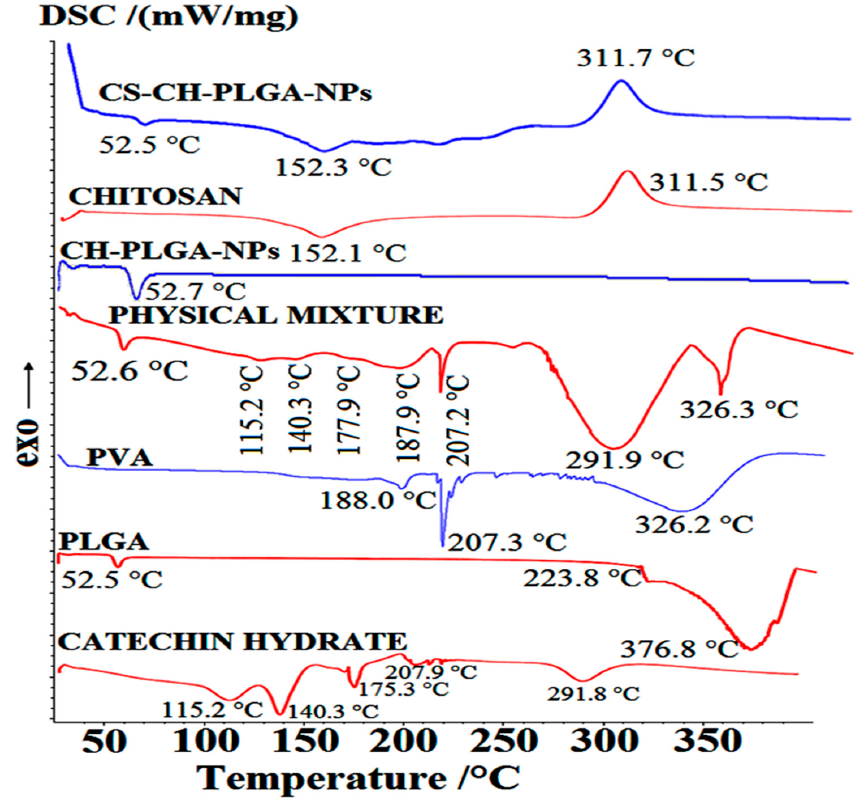
Figure 6. The differential scanning calorimetry (DSC) thermograms of pure catechin (CH); polymer (PLGA); polyvinyl alcohol (PVA); a physical mixture of CH, PVA, and PLGA;